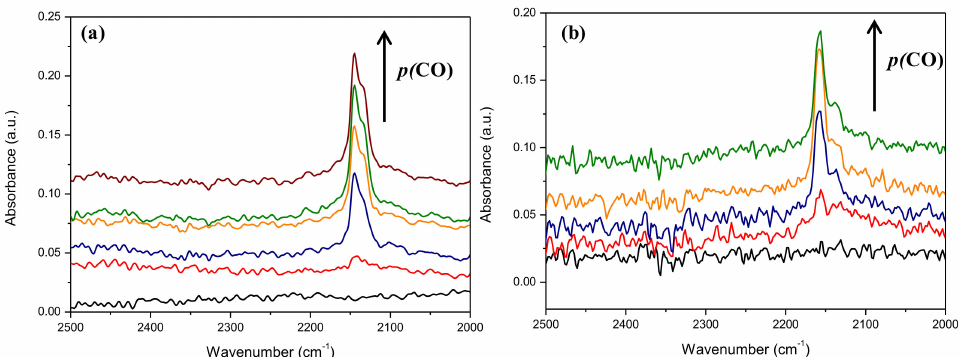
Figure 7. Di ff erent Fourier-transform infrared spectroscopy (FTIR) spectra of increasing amounts of CO adsorbed at low temperature (100 K): ( a ) MIL-53 (Al) and ( b ) Al-ITQ-HB (self-supporting wafer).